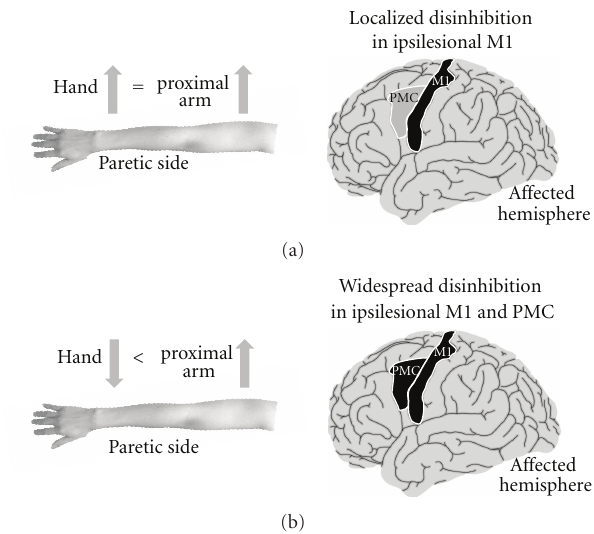
Figure 1: Maladaptive plasticity induced by disinhibition of motor- related areas in stroke patients. (a) Localized disinhibition in the ipsilesional primary motor cortex (M1). Localized disinhibition in the ipsilesional M1 promotes motor recovery by facilitating neural plasticity without competitive interaction between hand and proximal arm. (b) Widespread disinhibition in the ipsilesional M1 and premotor cortex (PMC). The disinhibition in the ipsilesional PMC causes uneven excitability distribution in the proximal arm and proximal-dominant competitive interaction in the ipsilesional M1 and PMC. As a result, this widespread disinhibition induces maladaptive plasticity that poorly controls the paretic hand in stroke